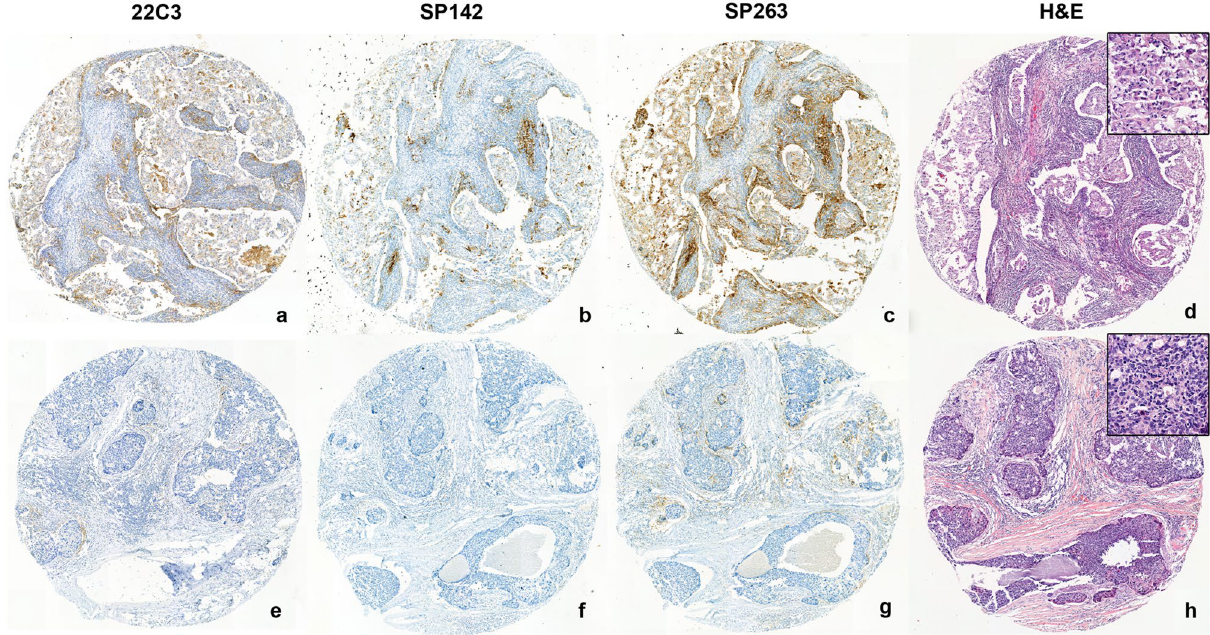
Figure 1. Positive and negative expression patterns of three PD-L1 antibodies. A representative case that showed triple-positive features for all three antibodies ( a – d ) exhibited > 90% of the stromal tumor-infiltrating lymphocytes (TIL) infiltration as well as intratumoral TIL. Discordant case which was positive for 22C3 and SP263 antibodies but lacked SP142 expression ( e – h ) presented with less TIL infiltration than that shown by the triple-positive case.